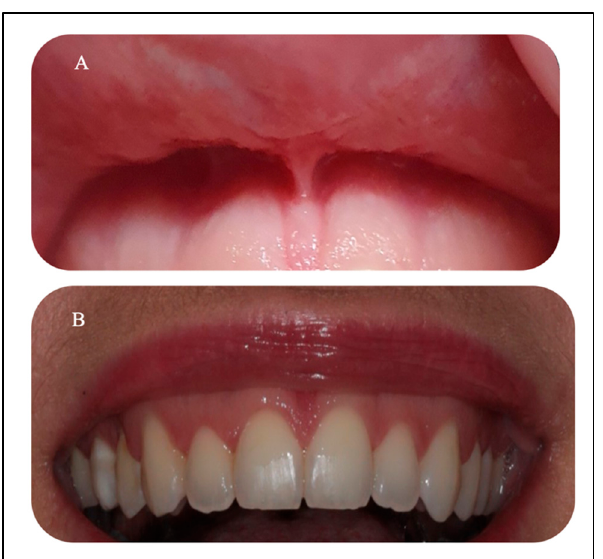
Figure 9. ( A , B ) Clinical photos of both laser treatments at six-months post-laser treatments. Photo ( A ) shows a complete healing of the upper midline frenum with new frenum attachment without evidence of functional relapse. Photo ( B ) shows a complete healing of the gingival tissue with a great improvement in the gingival margins of the upper incisor teeth.